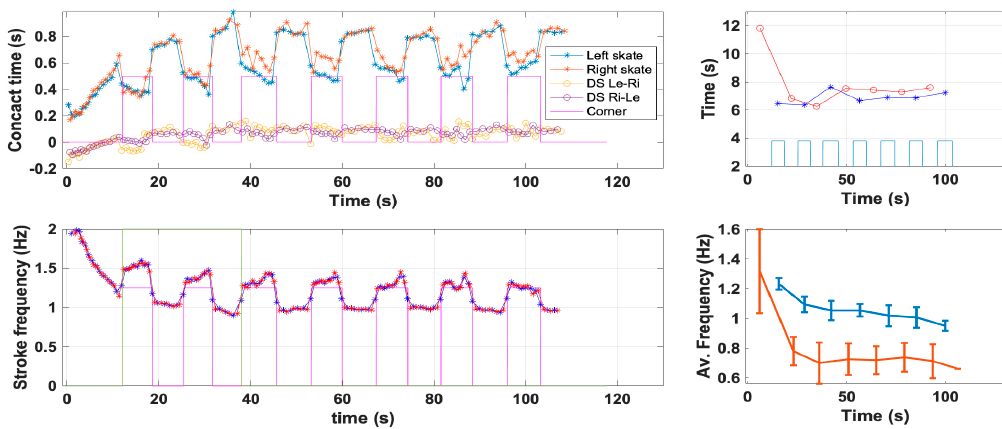
Figure 3. Basic feedback from a 1500 m race. On the left: contact-time ( top ) and stroke frequency ( bottom ). On the right: average contact time and average stroke frequency per segment (straightaway and